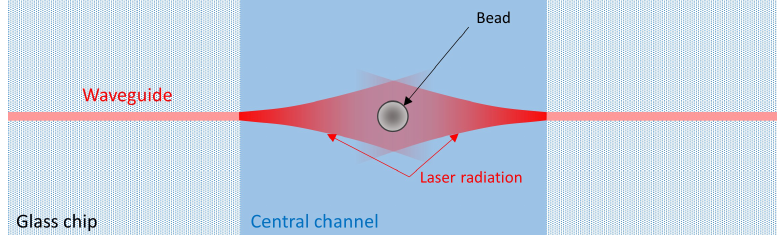
Figure 1. Schematic structure of an optical stretcher: a single bead is trapped between two facing non-focused Gaussian laser beams, with the same optical power, output by two integrated